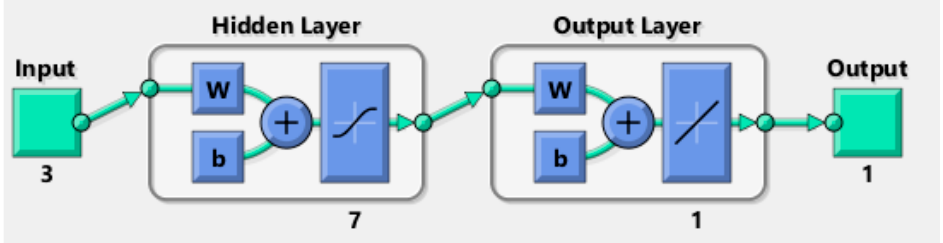
Figure 13. ANN architecture adopted in MATLAB.